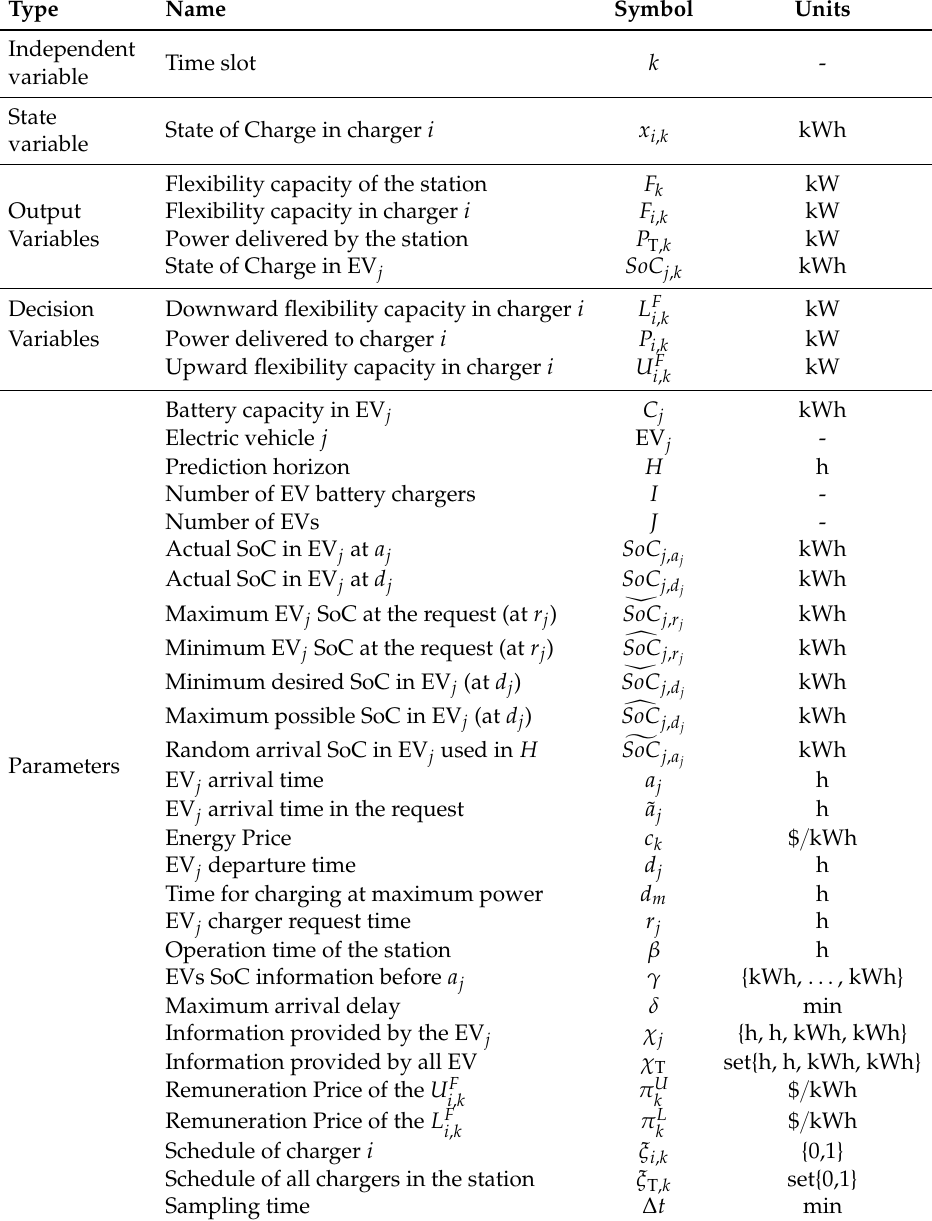
Table 1. Notation of the Electric Vehicle Charging Station